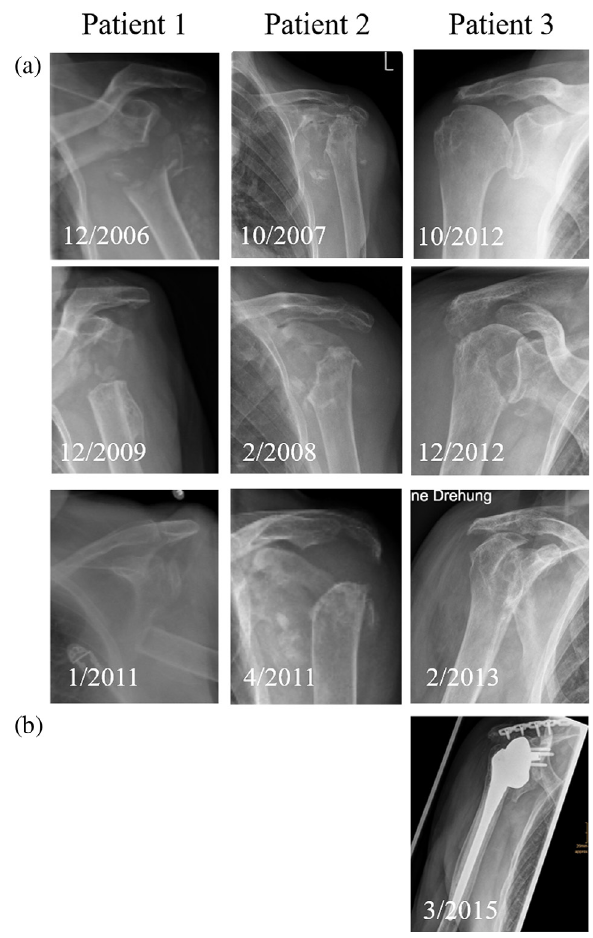
Figure 2. Antero-posterior radiographs of the involved shoulder of each of the three patients over time: (a) progressive osteolysis in all three patients; (b) implanted reverse shoulder prosthesis without loosening 12 months